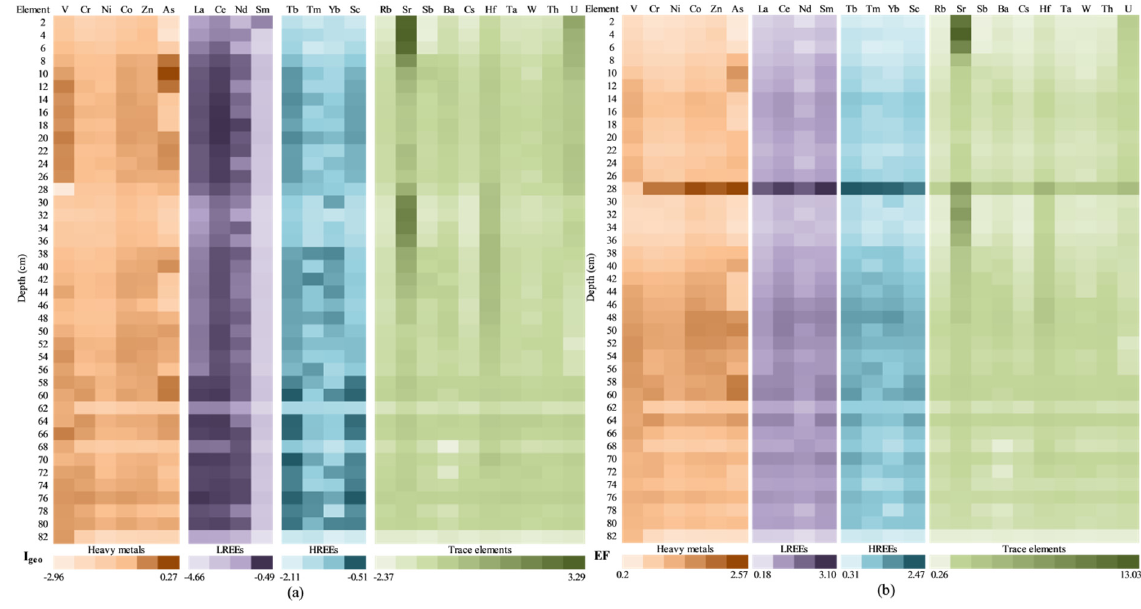
Figure 17. Geoaccumulation indices (I geo,s ) ( a ) and enrichment factors (EFs) ( b ) calculated from the Caineni Lake sediment core (82 cm depth).